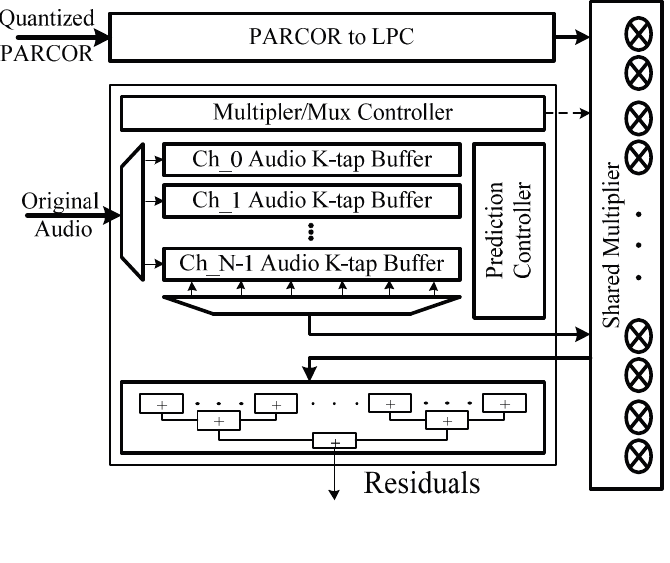
Figure 7. Block diagram of residual